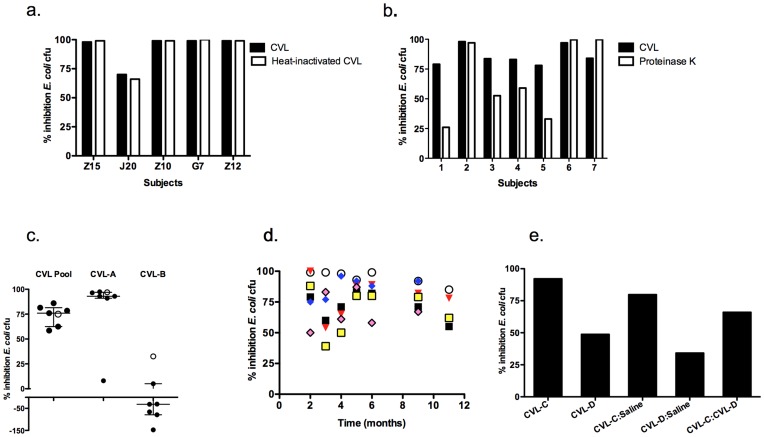
Stability of bactericidal activity.(a) Five lavage samples were tested for bactericidal activity before and after heat inactivation at 56°C for 30 minutes. Each bar is the mean percentage inhibition of colonies formed on duplicate plates; error bars are too small to be visualized. (b). Bactericidal activity was tested in seven CVL samples treated with or without 100 µg/mL of proteinase K. Each bar is the mean percentage inhibition of colonies formed on duplicate plates relative to control plates (bacteria treated with control buffer). (c) The bactericidal activity of a pool of five individual CVL samples and a randomly selected single CVL with high activity (CVL-A) and one with low activity (CVL-B) were tested against the lab strain of E. coli (open circles) or six clinical isolates. Each symbol represents mean percentage inhibition in cfu from duplicate plates relative to the control plates and the bars denote mean (sd). (d) Stored aliquots of CVL obtained from six subjects (each indicated by a different color symbol) were tested at the indicated intervals from time of collection up to one-year post collection. Each symbol represents the mean percent inhibition of E. coli cfu obtained from duplicate plates at the indicated times. (e) CVL from a subject with high activity (CVL-C) and less activity (CVL-D) were mixed 1∶1 with saline or with each other and then tested for ability to inhibit E. coli. Results are presented as percentage inhibition relative to control plates and are the means obtained from two independent experiments.